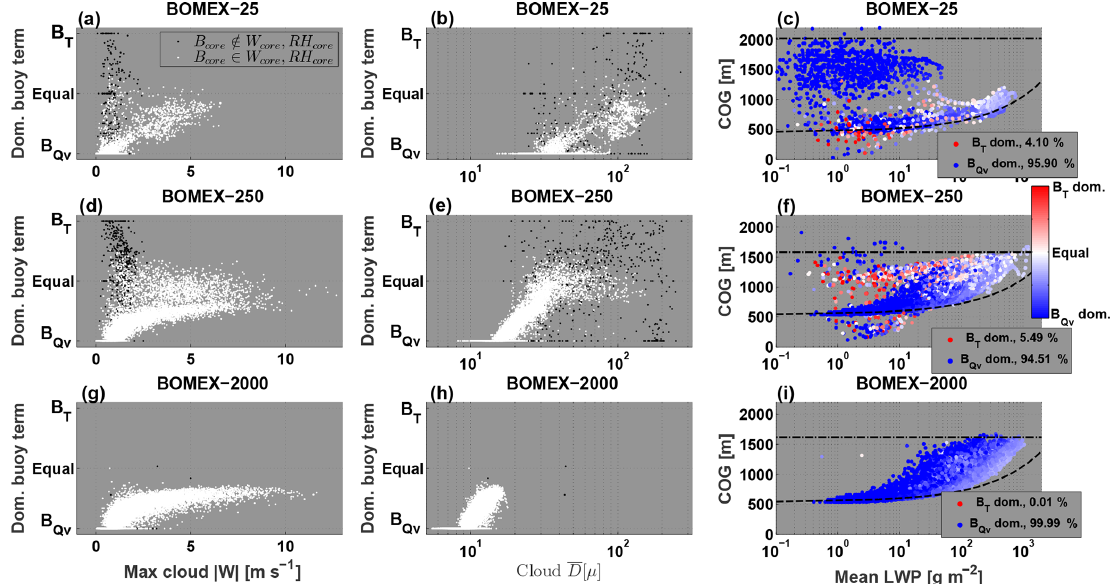
Figure 8. Analyses of dominant buoyancy term within B core of clouds (see text for details). As seen in previous figures, rows represent clean (top, a, b, c ), intermediate (middle, d, e, f ), and polluted (bottom, g, h, i ) simulations. Columns represent dependence on maximum absolute vertical velocity within cloud (a, d, g) , dependence on partition of total cloud mass to cloud droplets and rain drops (b, e, h) , and CvM space diagrams of all clouds with B core , where red (blue) shades indicate temperature (humidity) buoyancy terms that dominate the cloud (c, f, i) . Legends include percentage of clouds that are B T or B Qv dominated (see text for explanation).